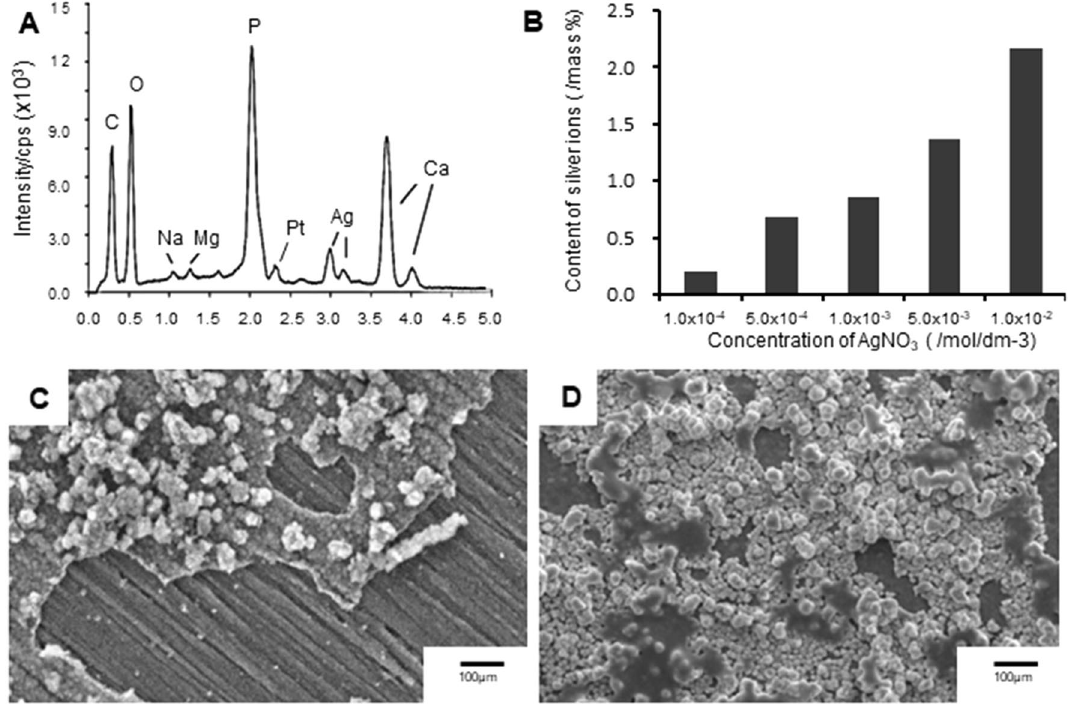
Figure 2. Microstructure and component analyses of the PEEK-Ag + . The surface of the PEEK-Ag + was qualitatively assessed using energy dispersive X-ray analysis (EDX) ( A ). The film consisted of Ca, P, O, C, and Ag. Inductively coupled plasma atomic emission spectrometry (ICP-AES) indicated that the Ag + ion content in the HAp film was dependent on the AgNO 3 concentration used ( B ). A peeling test showed that the HAp adhered poorly to the Ag + -coated PEEK prepared without H 2 SO 4 ( C ), while the H 2 SO 4 -immersed PEEK-Ag + adhered strongly enough to withstand being peeled off with tape ( D